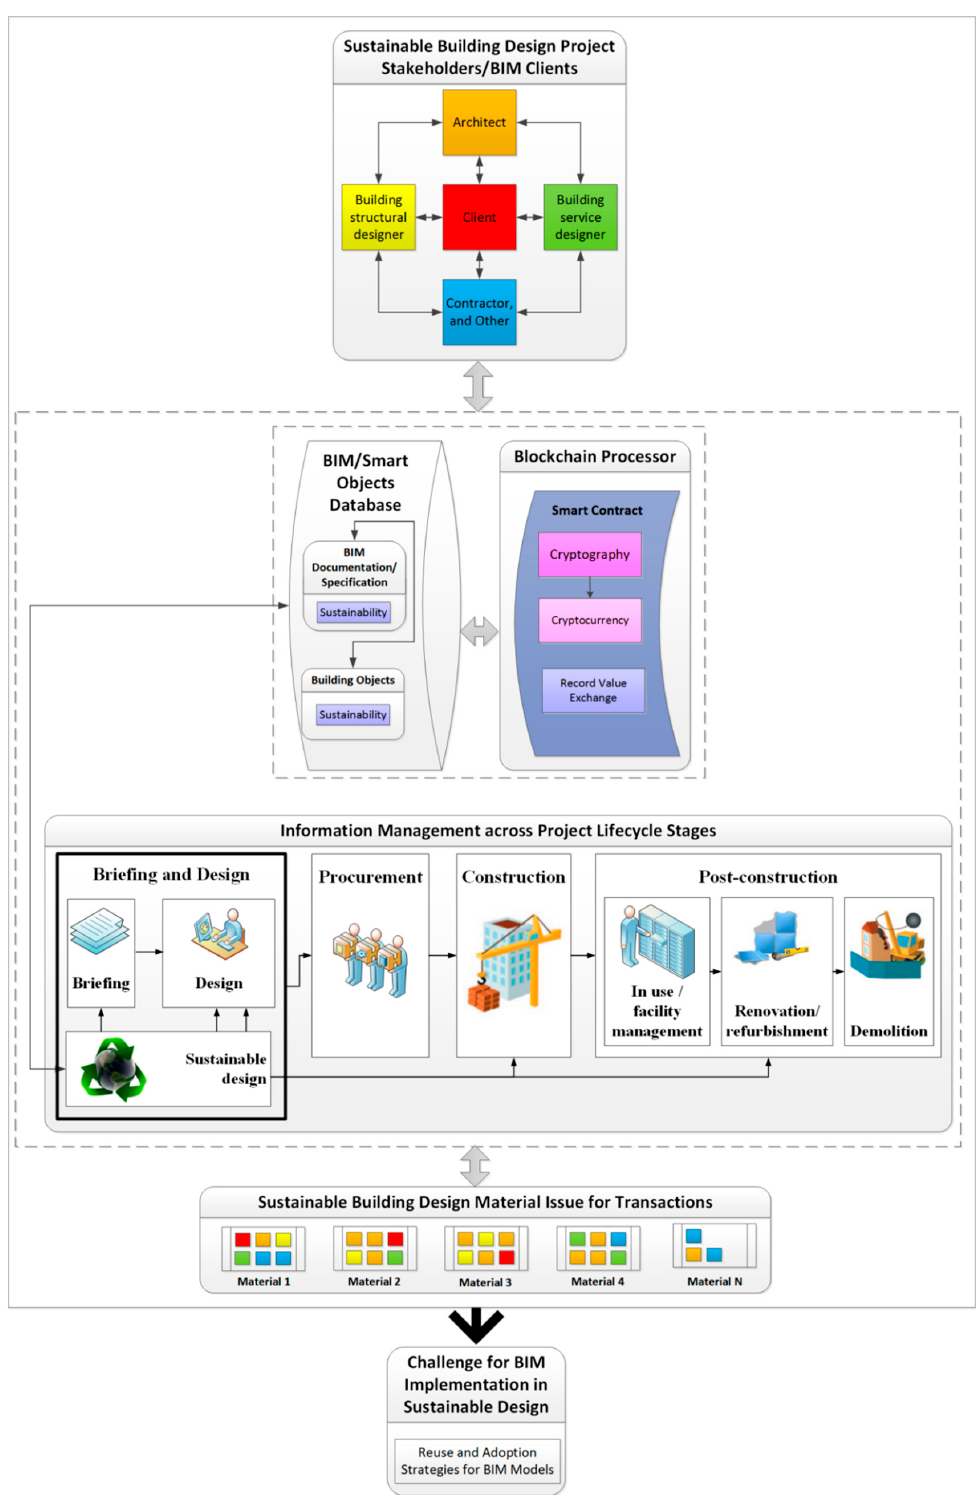
Figure 5. The updated user level (sustainable building design project stakeholders / BIM clients) driven and the smart contract enabled BIM + blockchain architecture to address a challenge of BIM for sustainable design in information management of building construction project management, i.e., reuse and adoption strategies for BIM models (devised by the authors based on the literature).